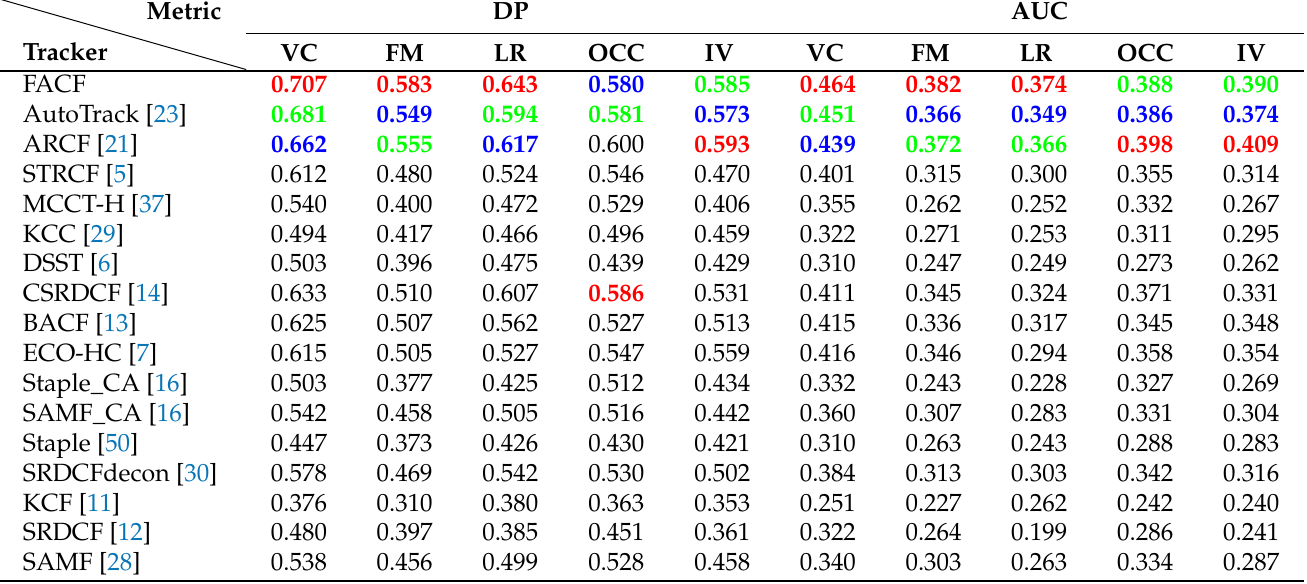
Table 2. AUC and DP scores of all trackers under UAV special attributes, including VC, FM, LR, OCC, and IV. Red , green , and blue denote the top three